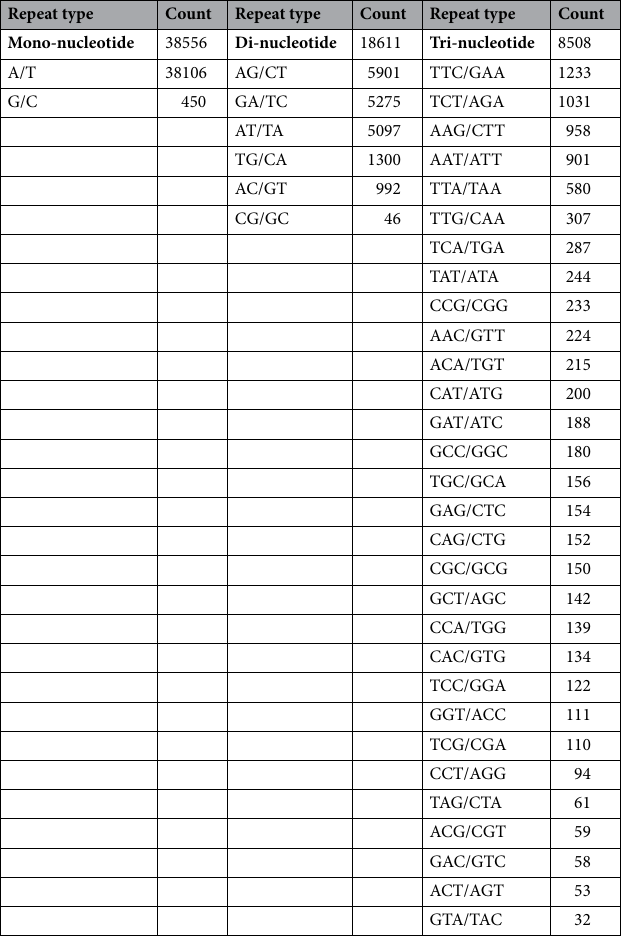
Table 4. Frequency summary of SSRs with different numbers of tandem repeats.